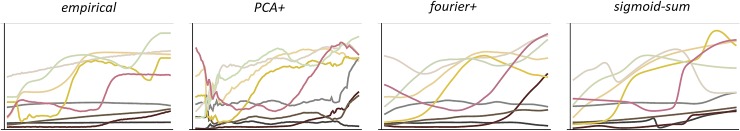
Synthetic reflectance functions (columns 2–4) colour-balanced with the same randomly chosen empirical reflectance functions as in Fig 11 (right).